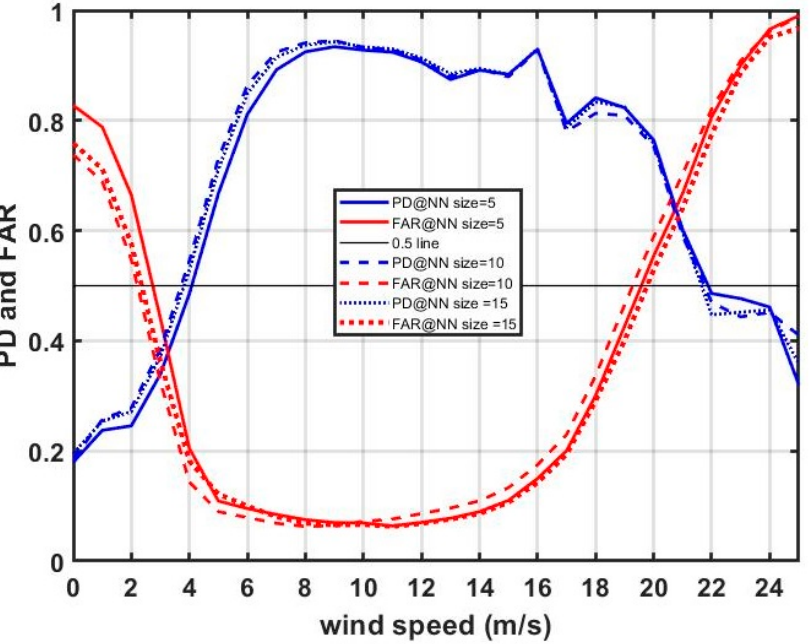
Figure 4. PD and FAR curves for 3 di ff erent network sizes (5, 10 and